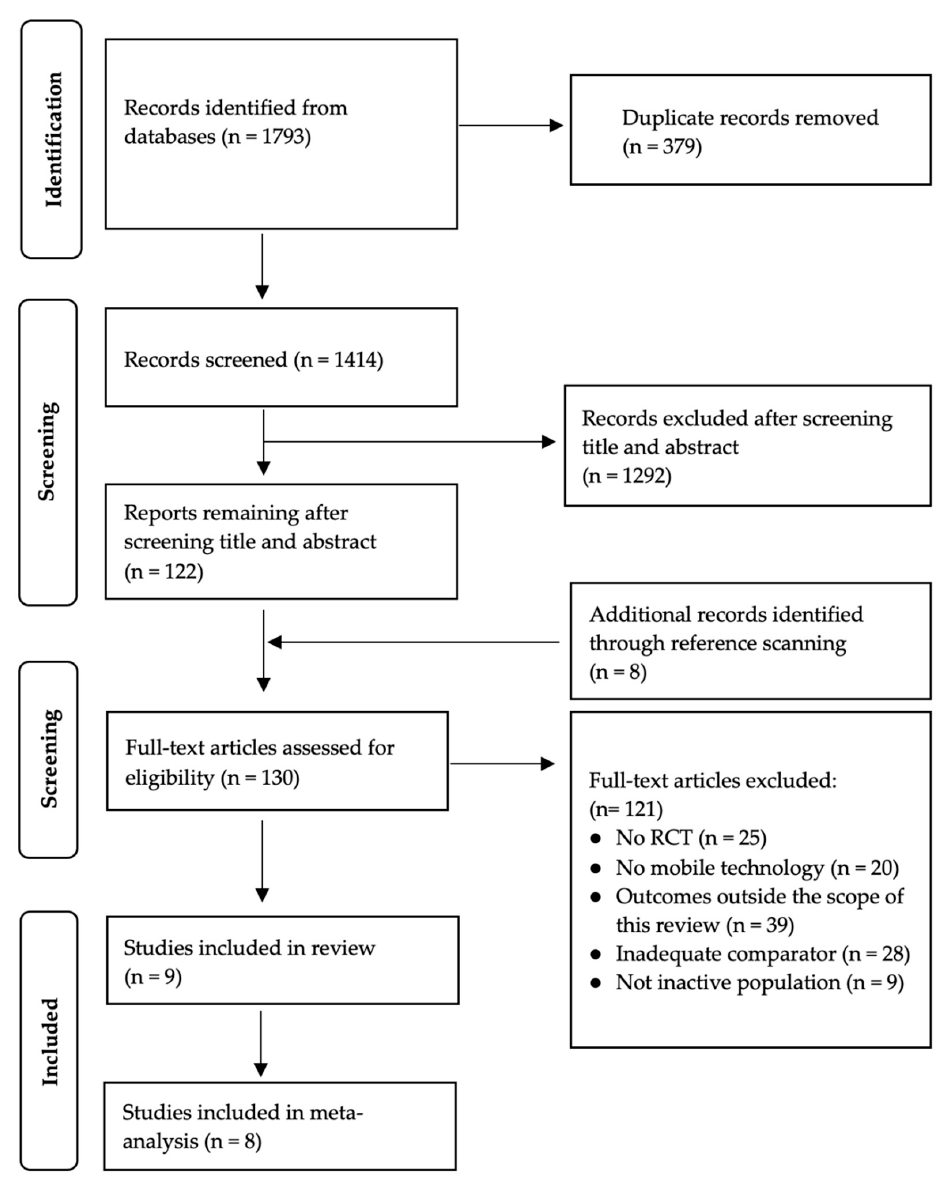
Figure 1. PRISMA flow diagram.